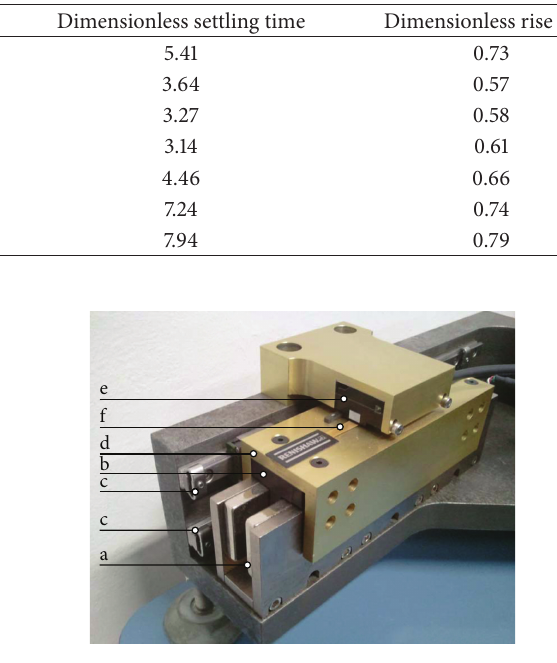
Figure 11: Experimental